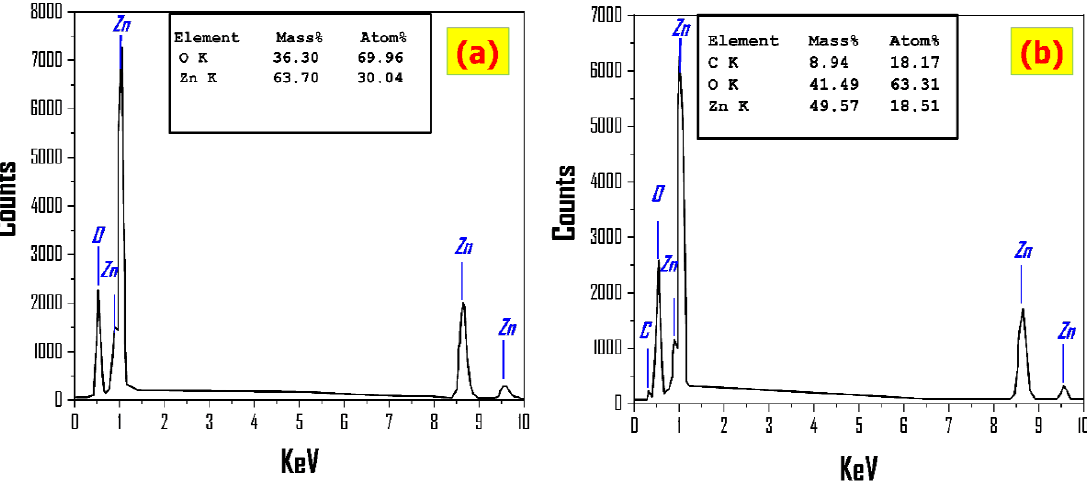
Figure 3. EDX patterns for ( a ) pure ZnO and ( b ) ZnO/CNTs, with the inset showing the chemical composition ratio.